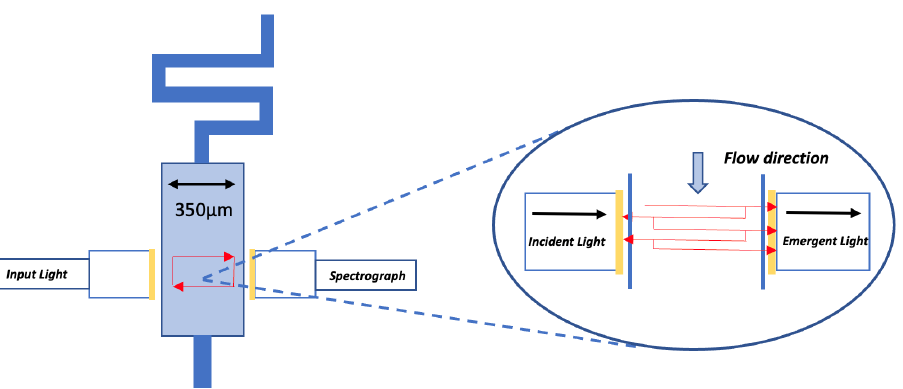
Figure 18. The use of gold-coated optical fibers as a F-P resonator for microfluidic detection. In- tegrated device with microfluidic reactor prior to the detection channel, plus schema of the F-P resonator traversing the detection cavity, augmenting the theoretical optical path length. Illustration adapted from Zhu et al. [119]. Printed with permission from Zhu et al. (2017). © 2017 Royal Society of